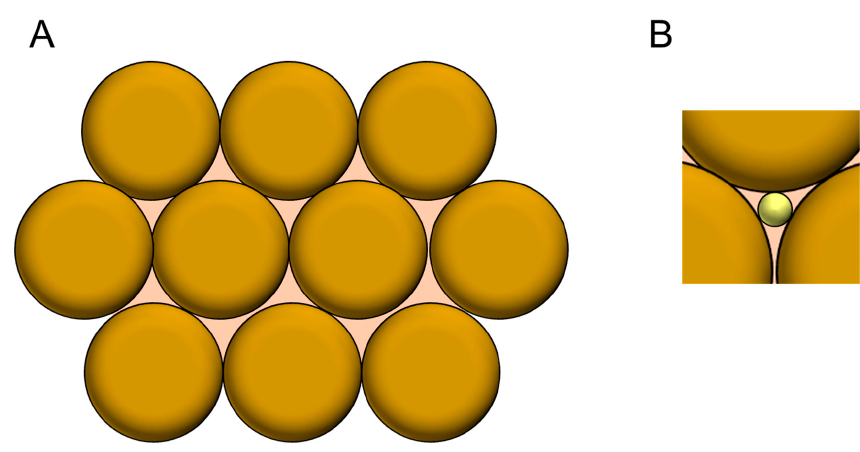
Figure 8. ( A ) A simple model of the aggregated nanoparticles. ( B ) Schematic view of an inscribed sphere in a pore between the closed packed spheres.